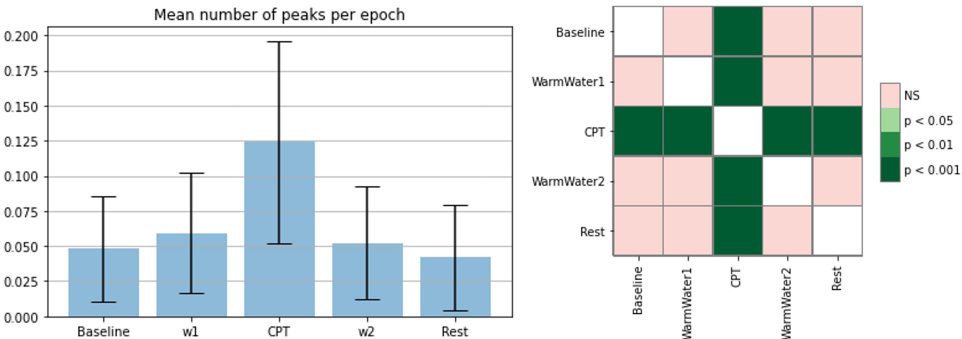
Figure 12. Bar chart of SCR peaks per second with corresponding standard deviation ( left ); p -values between different epochs, with Bonferroni correction ( right ).